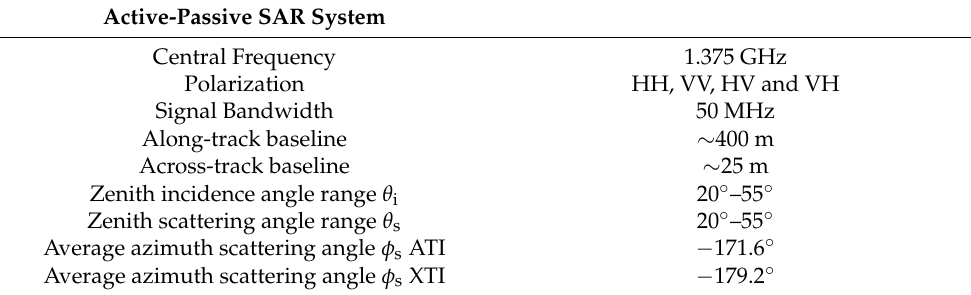
Table 1. The main characteristics of the Active-Passive Radar